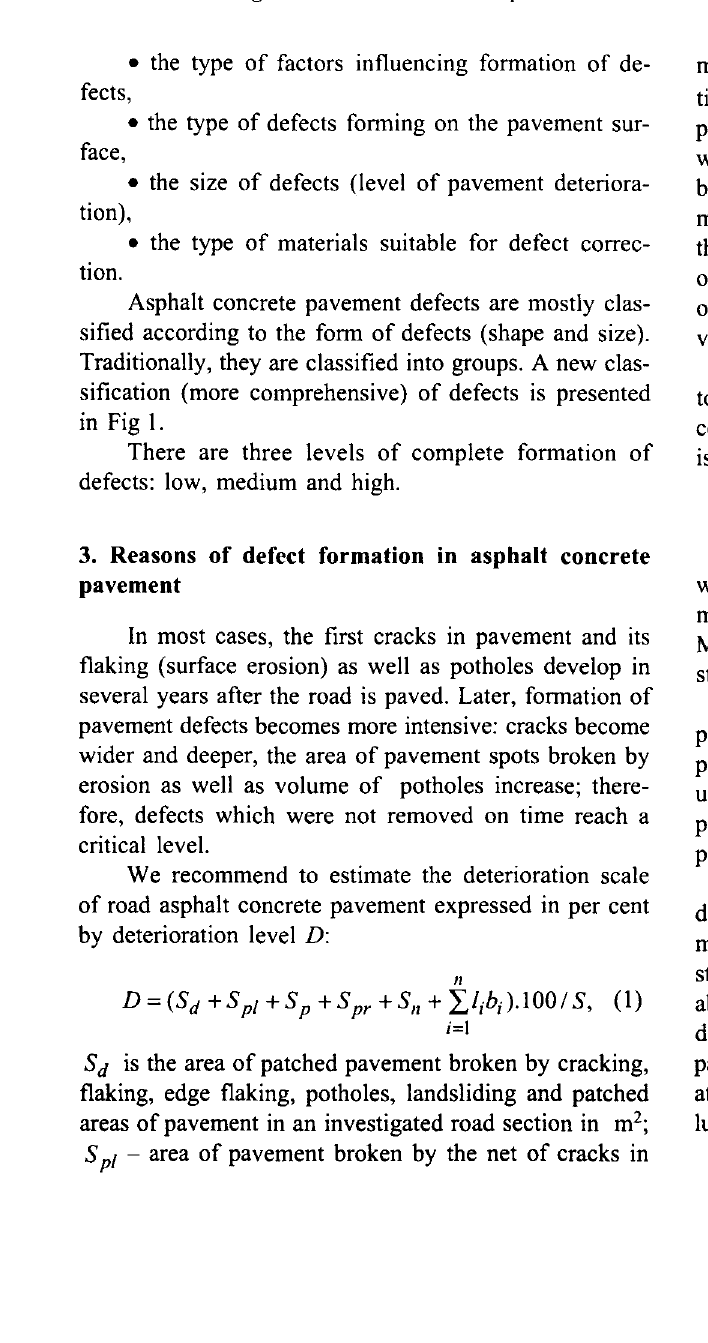
Fig 1. The classification of asphalt concrete road cover